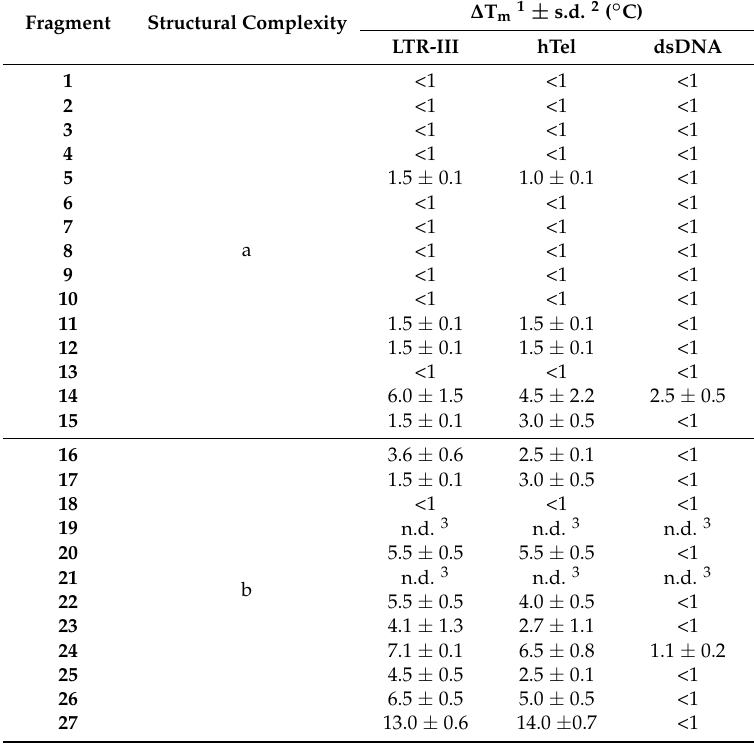
Table 1. Stabilization of LTR-III, hTel G4s and dsDNA (0.25 µ M) in the presence of 4000-fold excess of fragments (1 mM) vs. oligonucleotide, measured by FRET melting